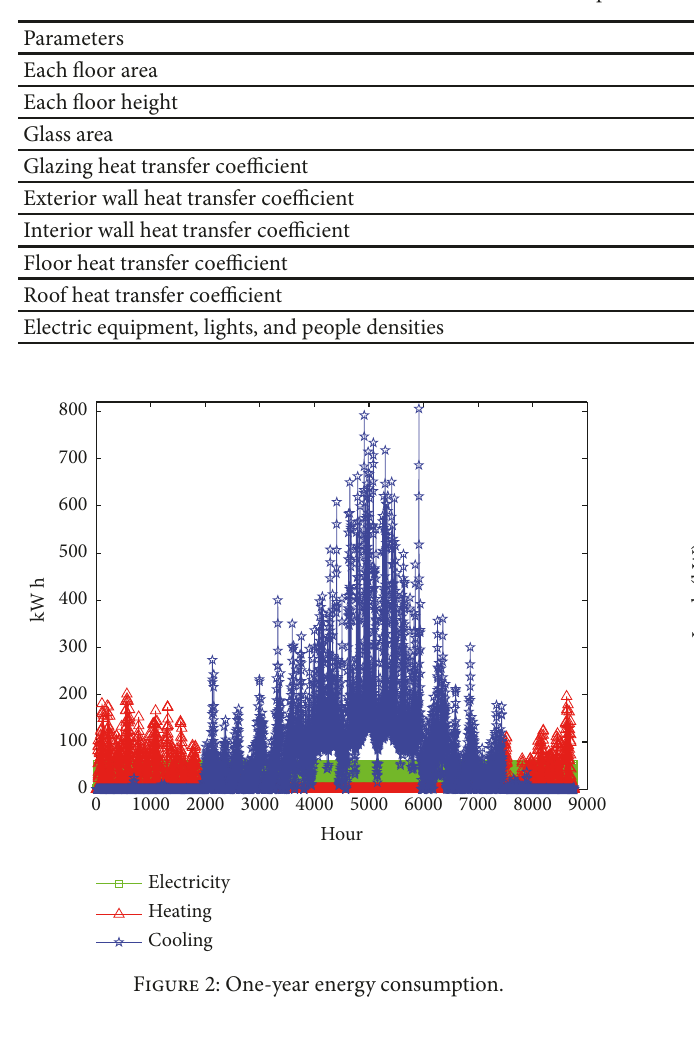
Table 1: Construction parameters of the office building.